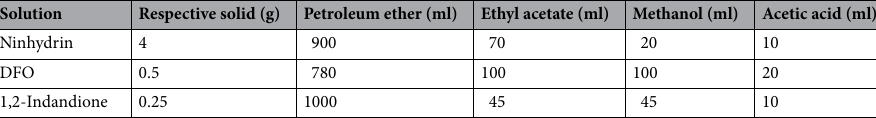
Table 1. Working solution quantities for fingermark reagents.